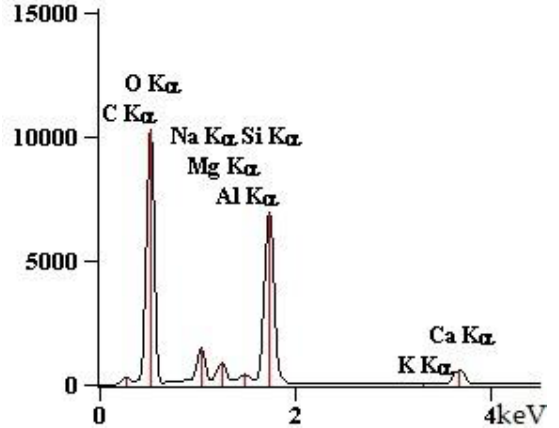
Figure 21. EDS spectrum of brick modified with 90% GS. Point 1.